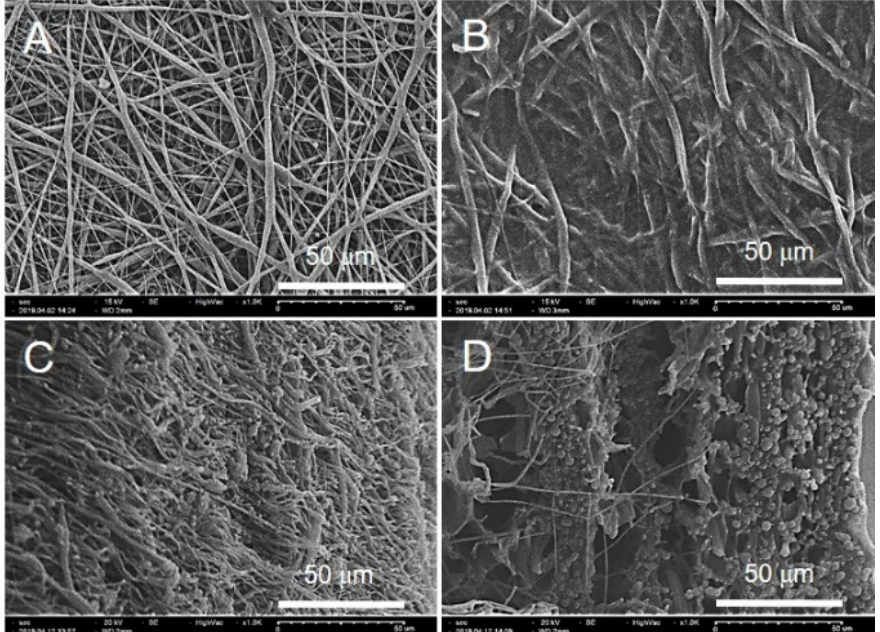
Figure 2. SEM images: ( A ) PCL surface, ( B ) GO/PVP-PCL surface, ( C ) PCL cross-section, and ( D ) GO/PVP-PCL cross-section.